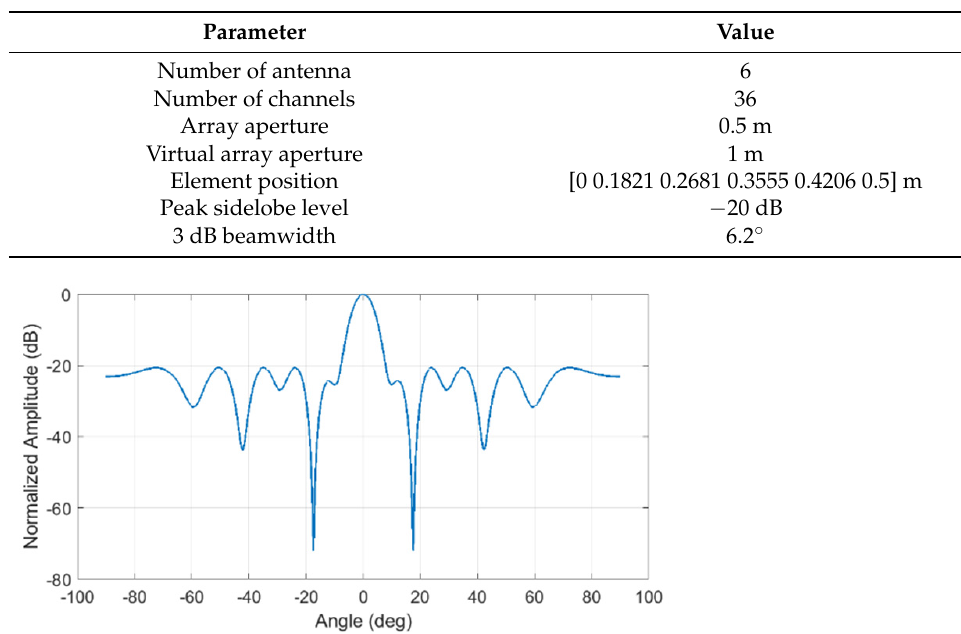
Table 2. Array parameters.